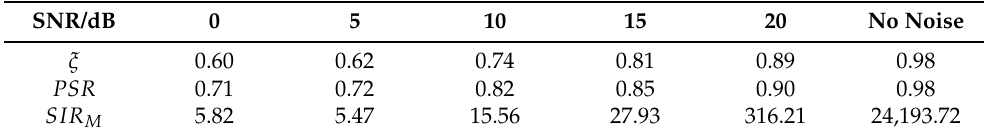
Figure 8. Time-domain waveforms and time–frequency diagrams of estimated signals. ( a , b , d ) show the time-domain waveforms of estimated signals and ( c , e , f ) show the time–frequency diagrams. Table 4. Separation performance at different SNRs.